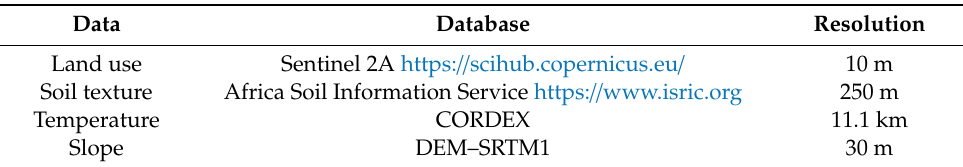
Figure 3. Land suitability factors ( a ) soil texture, ( b ) slope, ( c ) land use, ( d ) T baseline, ( e ) T projected under RCP4.5, ( f ) T projected under RCP8.5.